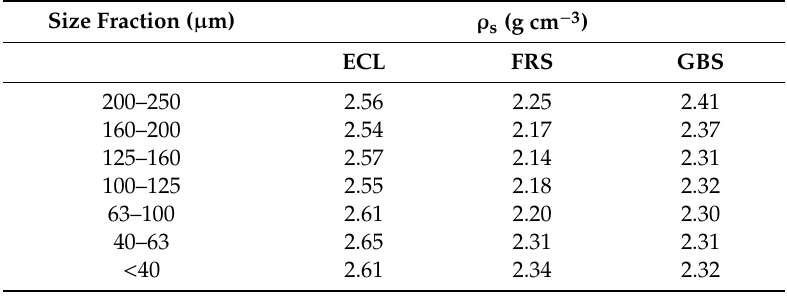
Table 3. Particle density ( ρ s ) of the fractionated samples ECL, FRS, and